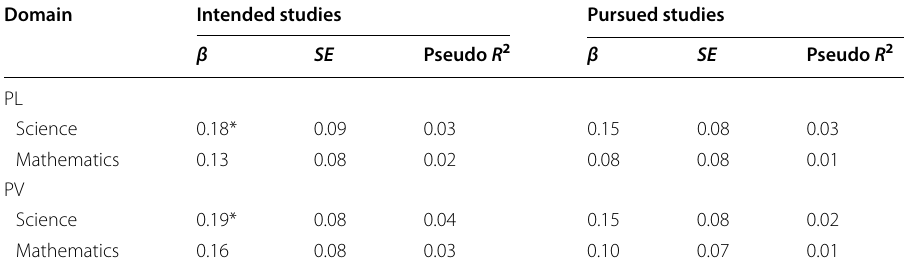
Table 6 Effects of PL placement and ability in science and mathematics on studies in science